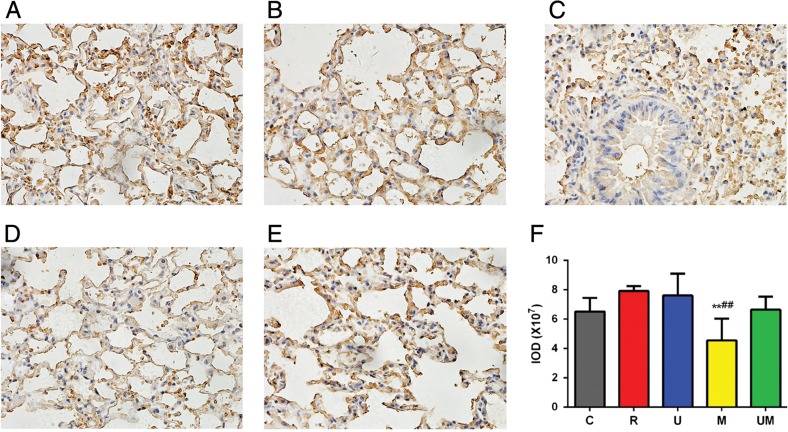
Expression of TGF-β1 in lung tissue at 9 weeks after radiation in each group. TGF-β1 expression was evaluated in the alveolar interval, bronchioli smooth muscle, vascular smooth muscle, vascular endothelium, and perivascular space. The expression levels in these areas were not statistically different between Groups C, R, U, and UM (A, B, C and E). TGF-β1 expression was significantly downregulated at 9 weeks in Group M compared with levels in Groups C and R (both P < 0.01, D and F).